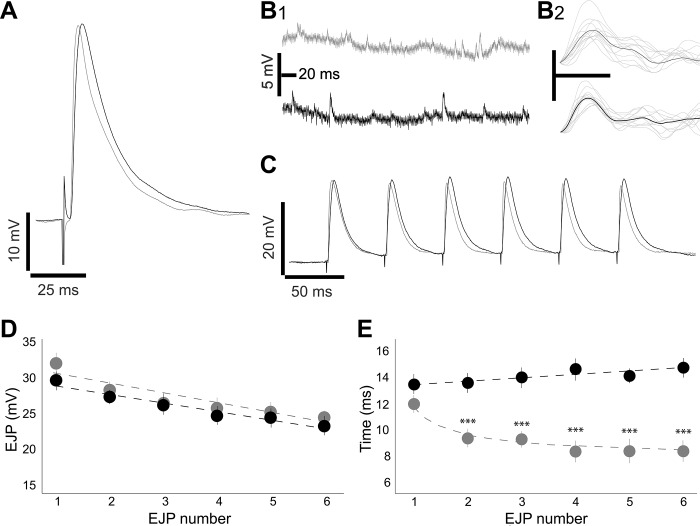
Evoked and spontaneous synaptic activity is normal, while EJP decay time is reduced upon successive stimulation, in glial tau transgenic larvae.(A) Evoked excitatory junction potential waveform is similar between control (black) and glial tau transgenic (grey) NMJ (n = 89, 69, respectively, p = 0.51 amplitude and p = 0.20 decay time, t-tests). (B) Spontaneous miniature end plate potentials occurred at similar frequencies and amplitude (B1). Mini waveforms (B2) were similar between control and glial tau transgenic larvae (n = 46, 48, respectively, peak amplitude: p = 0.42, t-test). (C) An example muscle recording upon presentation of brief (300 ms), high frequency (20 Hz) stimulus train to the motoneuron. (D) Peak compound EJP amplitudes were not statistically different in control and glial tau transgenic larvae (p = 0.45). (E) In contrast, EJP decay time decreased with stimulus number in glial tau transgenic larvae (e.g. stimulus 6 vs. stimulus 1, ***p<0.001, Friedman’s ANOVA), while EJP decay time was unaffected in control larvae across stimuli (p>0.05, ANOVA). EJP decay time was thusly significantly reduced in glial tau transgenic larvae, compared to control (p<0.0001, Friedman’s ANOVA). Crosses were performed at 28°C.